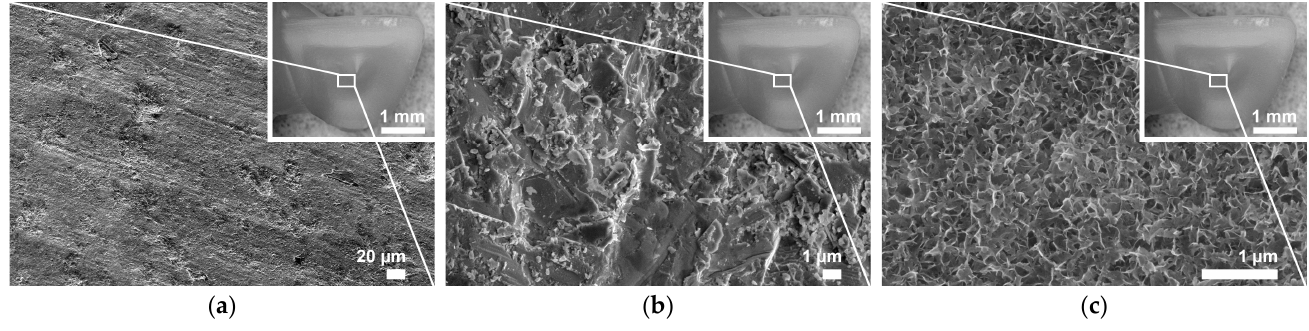
Figure 5. SEM micrographs showing the microstructure of zirconia representative retainer wings’ bonding surface after different pretreatments. ( a ) AM smooth surface with shallow milling traces (original magnification × 250); ( b ) APA surface exhibiting severe surface abrasion, consisting of pits and sharp cuts (original magnification × 5000); ( c ) NAC-modified surface uniformly covered with lamellar-like coating, exhibiting no voids and exposed zirconia grains (original magnification ×20,000). AM , as-machined; APA , airborne-particle abrasion; NAC , nanostructured alumina coat- ing.